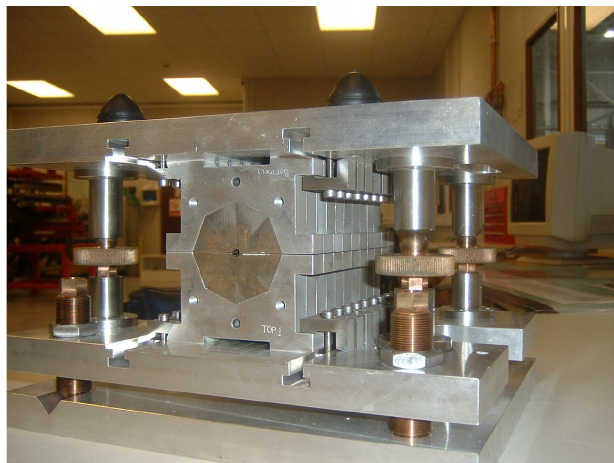
FIG. 6. (Color) Photograph of completed PM ring undulator assembly, with ten 14 mm periods.